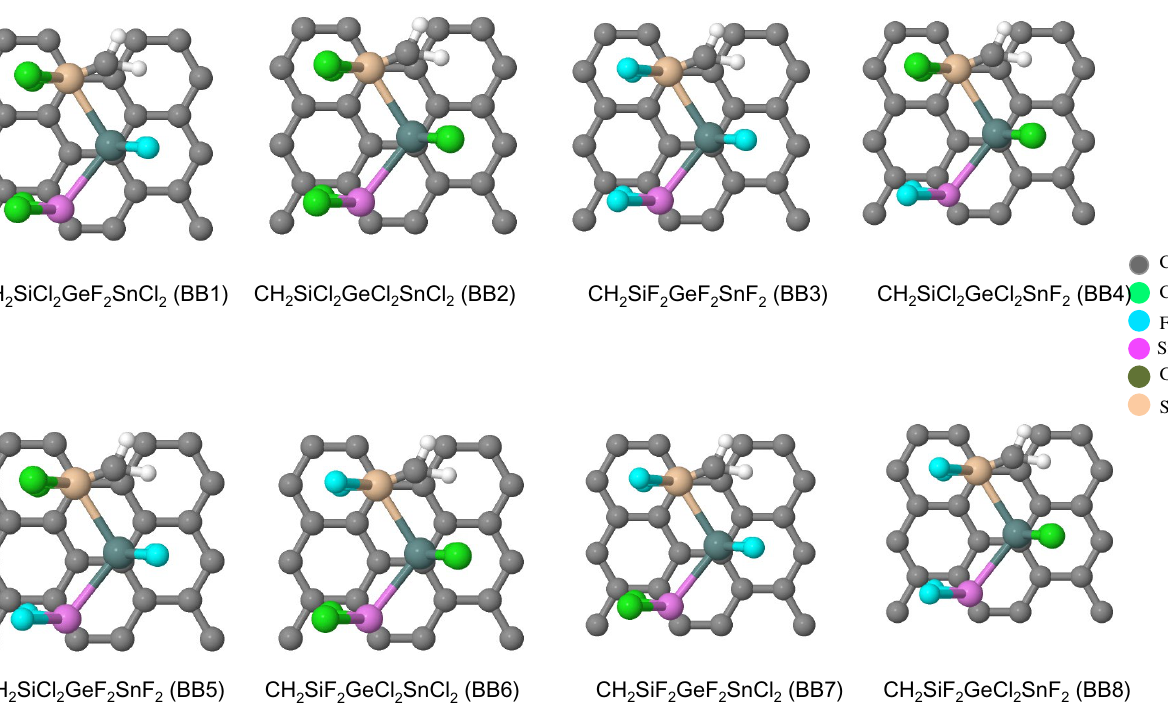
Figure 1. Material motifs. Examples of a 1D Chain polymer with different building blocks (BBs) adsorbed on graphene (GE). Building blocks of CH 2 SiCl 2 SnF 2 GeCl 2 (BB1), CH 2 SiCl 2 SnCl 2 GeCl 2 (BB2), CH 2 SiF 2 GeF 2 SnF 2 (BB3), CH 2 SiCl 2 GeCl 2 SnF 2 (BB4), CH 2 SiCl 2 GeF 2 SnF 2 (BB5), CH 2 SiF 2 GeCl 2 SnCl 2 (BB6), CH 2 SiF 2 GeF 2 SnCl 2 (BB7),